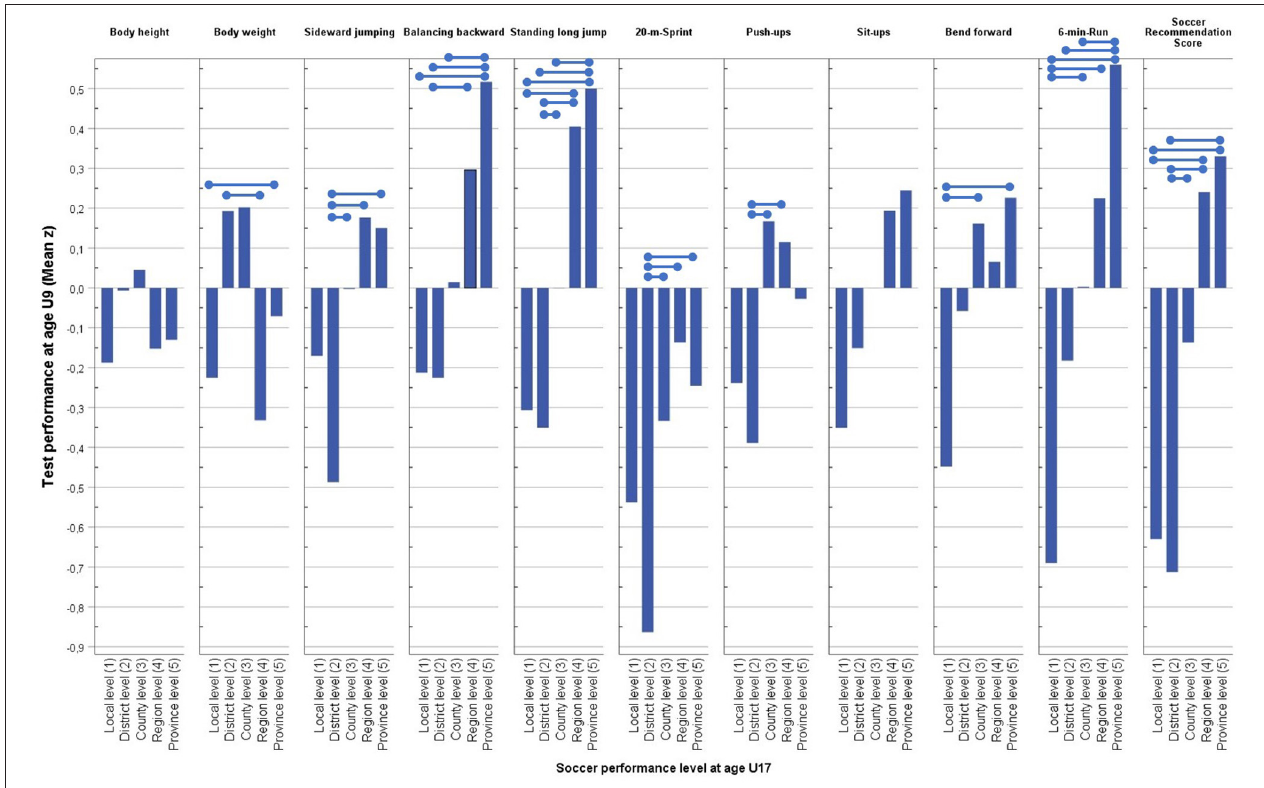
FIGURE 5 | Age-adjusted and z -standardized test performances of the U9 participants in regard to the later competition performance levels at adolescence (U17). Data of the 20-m sprint were transformed into positive direction. Variances of subgroups were homogeneous, but not in body weight [Levene (4;488) = 5.39; p < 0.001]; significant differences (Bonferroni post-hoc test; p < 0.05) between subgroups are marked by connection